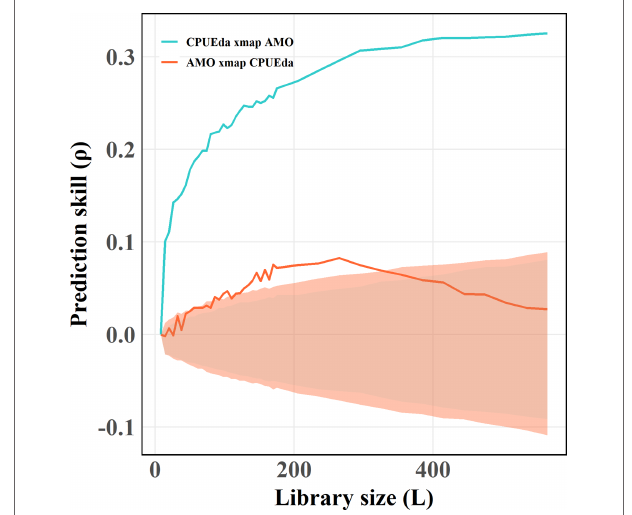
FIGURE 4 | Results of the CCM applied to the nonlinear dynamics of CPUEda and AMO. The blue lake and bright orange lines represent the effect of AMO on skipjack and the opposite effective direction, respectively. The different color shadows represent the 95th percentile of the results of CCM for the surrogate data versus the original effect time